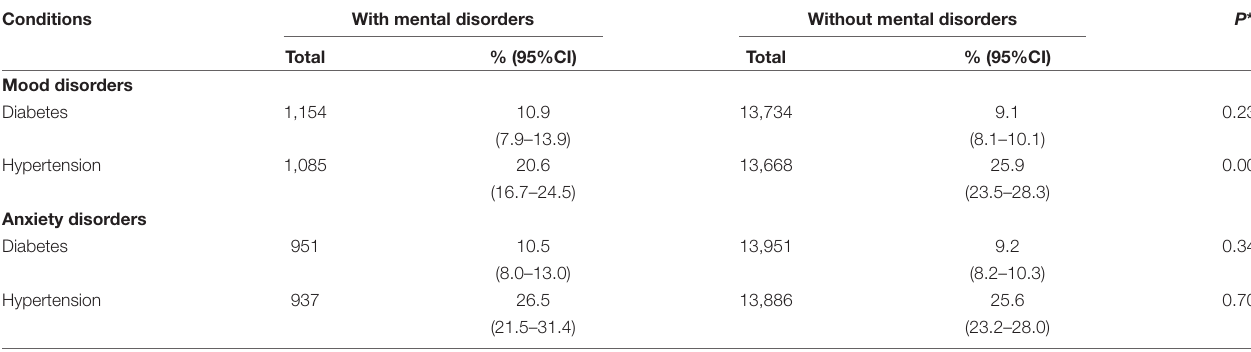
TABLE 1 | Comparison of weighted prevalence of physical diseases between patients with and without mental disorders.